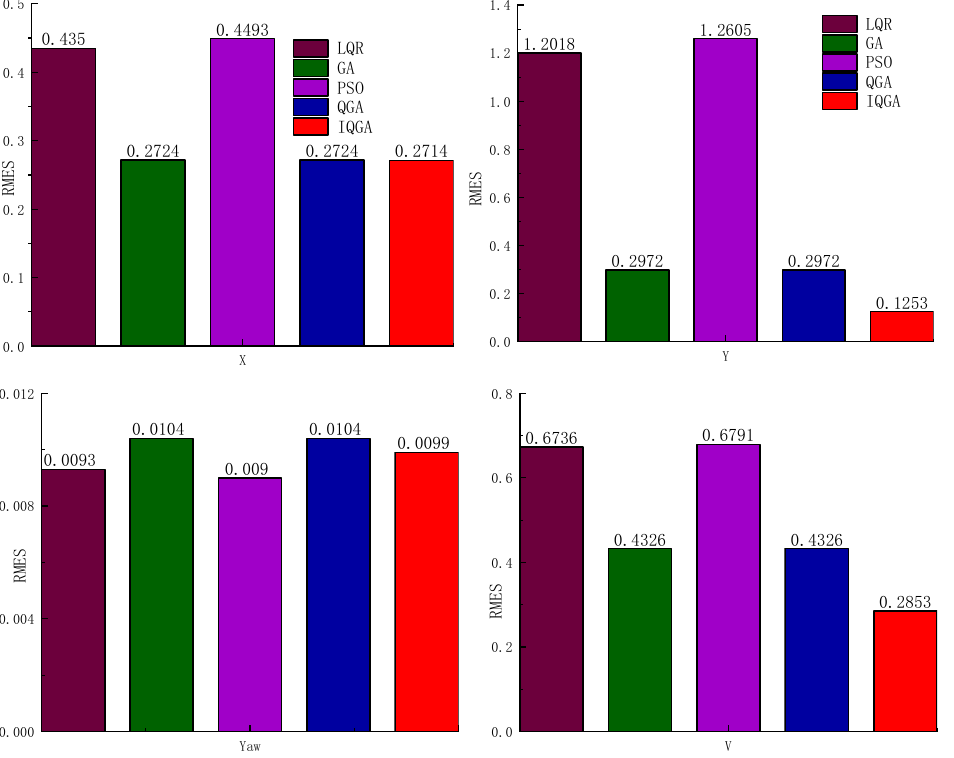
Figure 9. Motion state RMSE values when tracking circular trajectories.